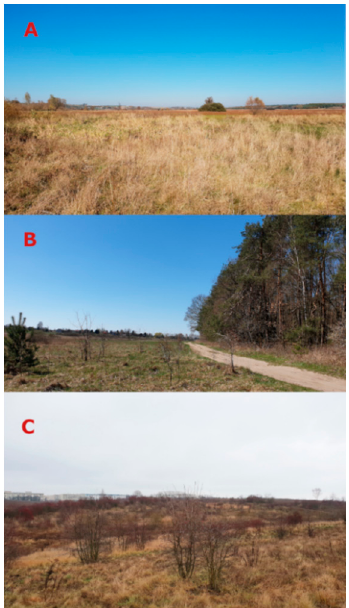
Figure 1. Localities of the research plots. ( A ) plot located in an open meadow, ( B ) plot located in the immediate vicinity of a mixed forest, ( C ) plot located within administrative city limits surrounded by buildings.